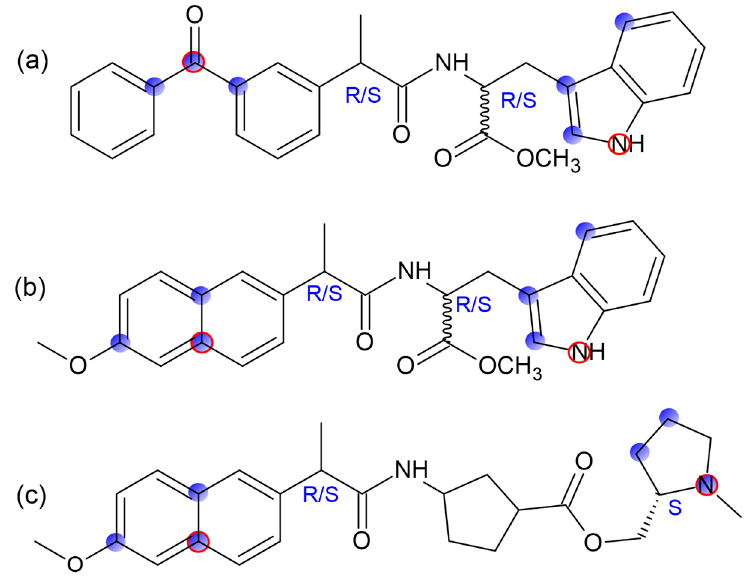
Figure 3. Selection of atoms for distance calculation (red circles) and planes for angle calculation (blue circles) in dyad ( a ) IV, ( b ) III, and ( c ) II. Table 7. Times of being at a certain distance of ( R,S )-, ( S,R )-, and ( S,S )-configuration of dyads IV–II and angles between plane of donors and acceptors in the solution of acetonitrile (mean values from 10 trajectories with the duration of 100 ns).